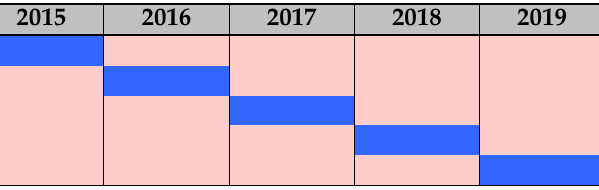
Table 3. Implementation of the routine for comparing the performance of the ML models. Training (pink) and testing (blue)